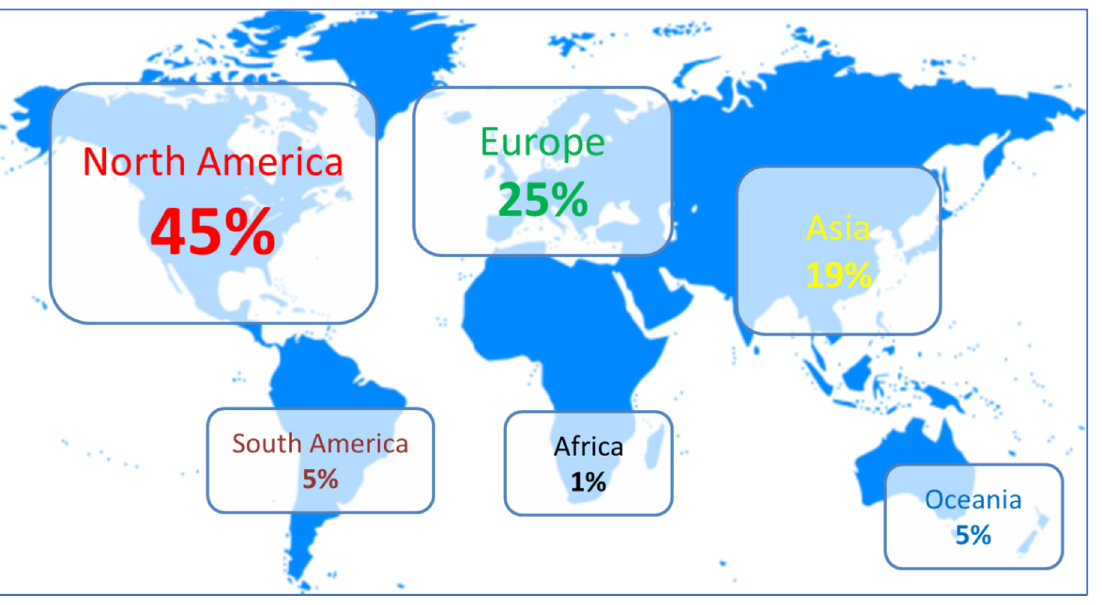
Figure 2. Industrial implementation of HPP technology by geographical region, as of 2019 (almost 600 industrial HPP machines run in production globally).